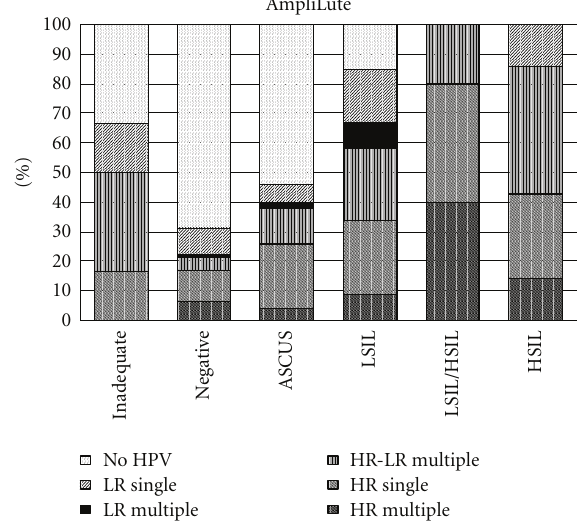
Figure 1: Prevalence of HR-HPV and LR-HPV types according to cytological diagnosis as detected by the AmpliLute extraction